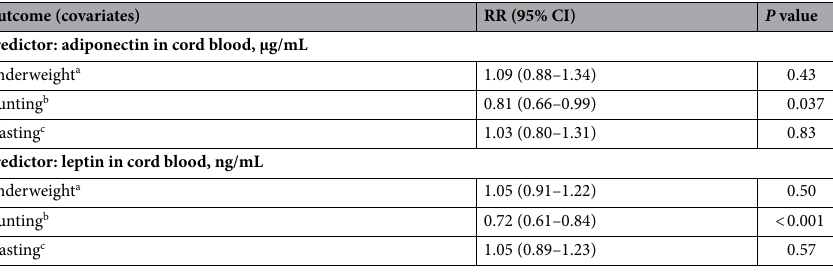
Table 4. Multivariable generalized estimated equation models of continuous adiponectin and leptin levels predicting underweight, stunting, and wasting during infancy. a Adjusted for maternal age, socioeconomic status (SES), sex, and weight-for-age z-score at birth. b Adjusted for SES, exclusively breastfeeding, and height- for-age z-score at birth. c Adjusted for maternal age and